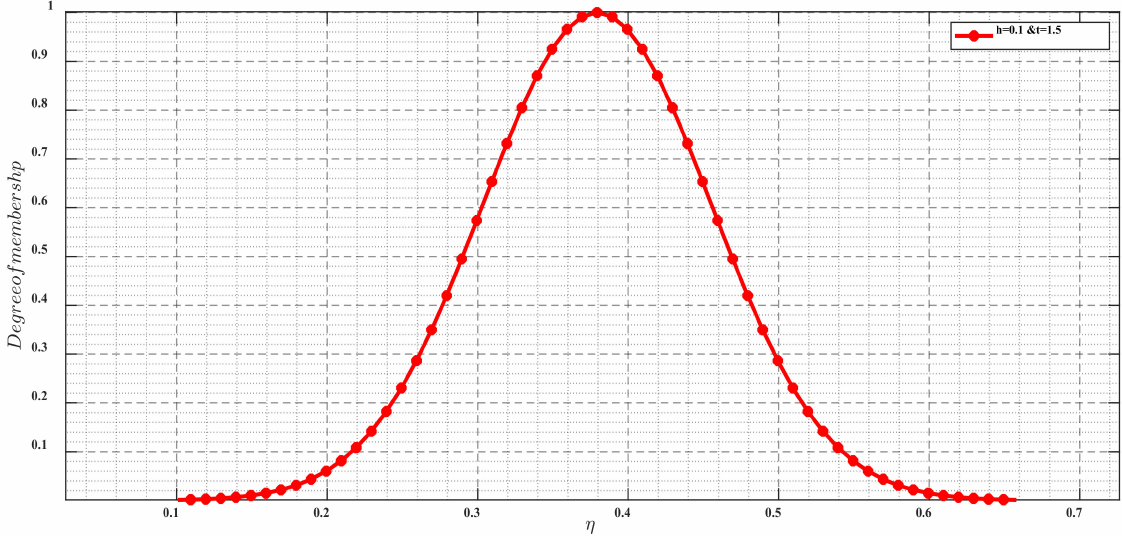
Figure 13. Fuzzy solution of η by SHPM at t = 1.5 s ( h =